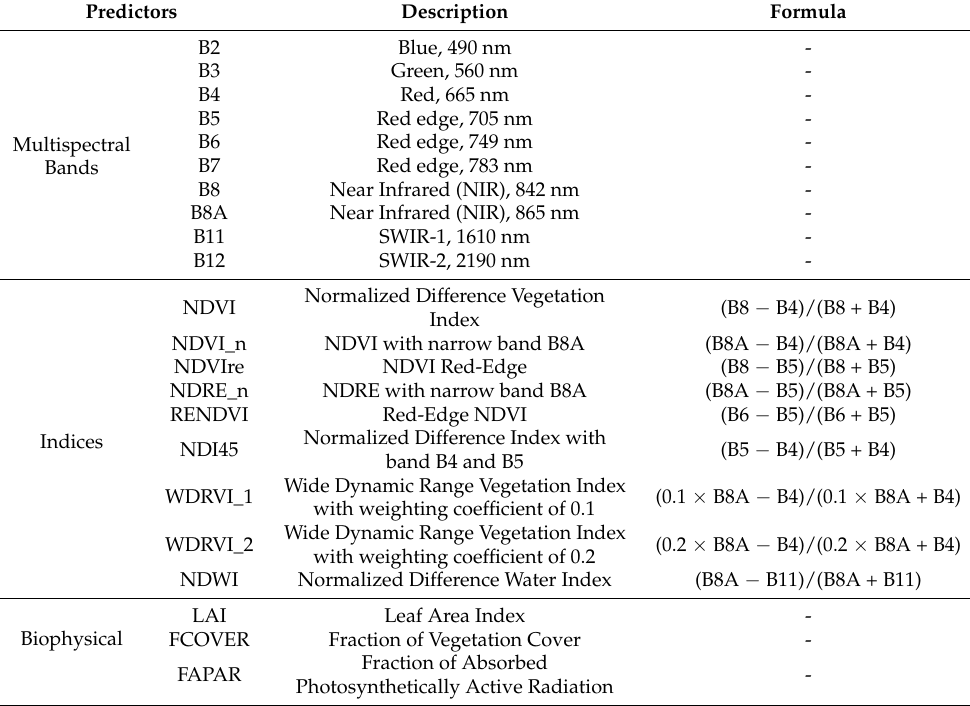
Table 4. List of Sentinel-2 predictors used for the aboveground biomass (AGB)